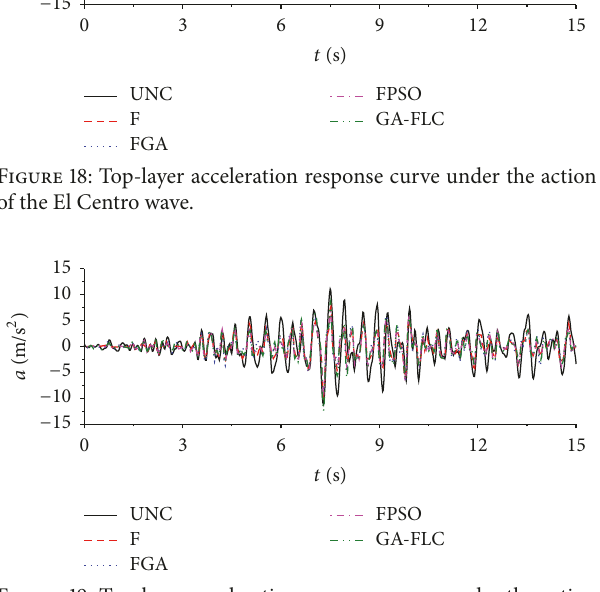
Figure 15: Top-layer displacement response curve under the action of the El Centro wave.